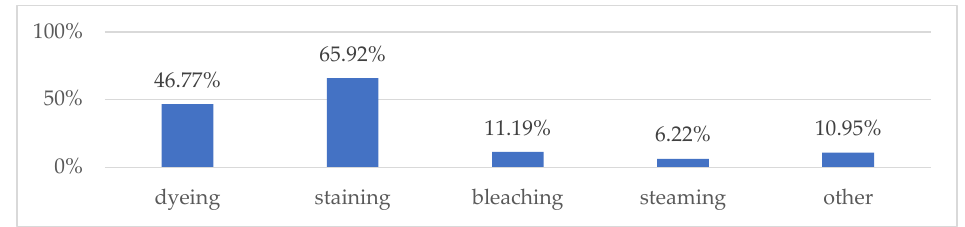
Table 2. Binomial test results for the hypothesis H1—WFEs.